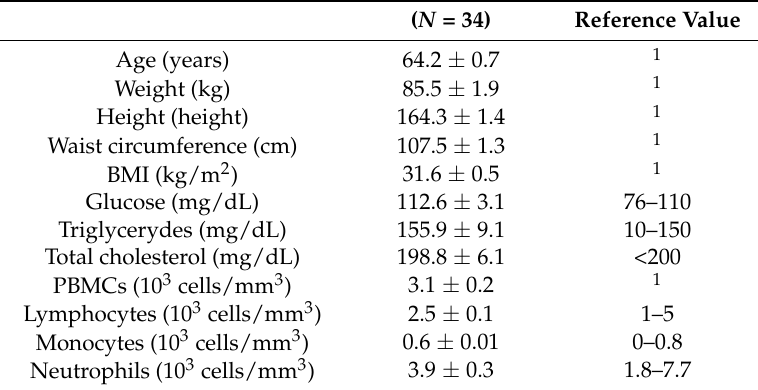
Table 2. Anthropometric and haematological characteristics of the participants.